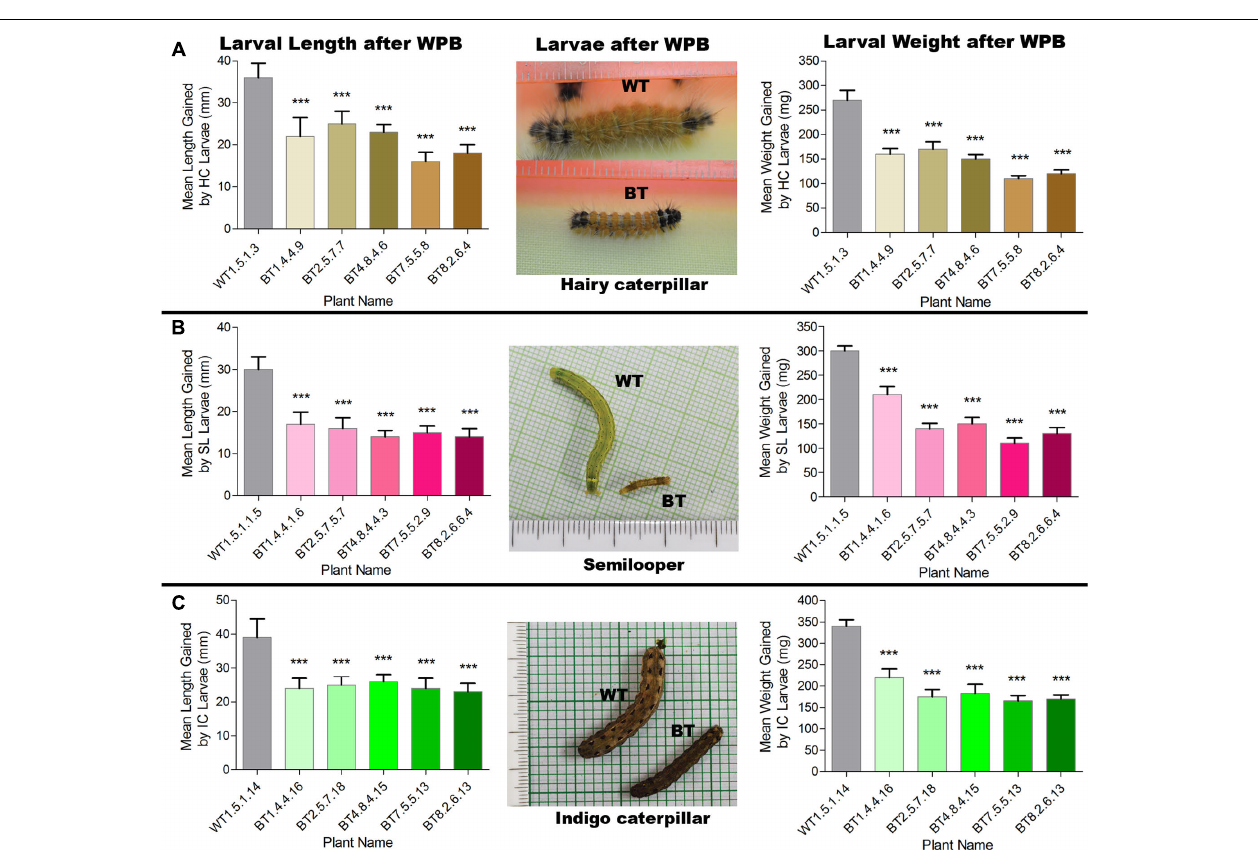
FIGURE 8 | Comparative analyses of mean length and weight gained by larvae (A) HC, (B) SL and (C) IC after whole plant bioassay (WPB) on host Bt jute (BT) and non-transgenic (WT) plants. Significant difference ( P < 0.001) denoted as ∗∗∗ in Bt jute compared to WT jute.